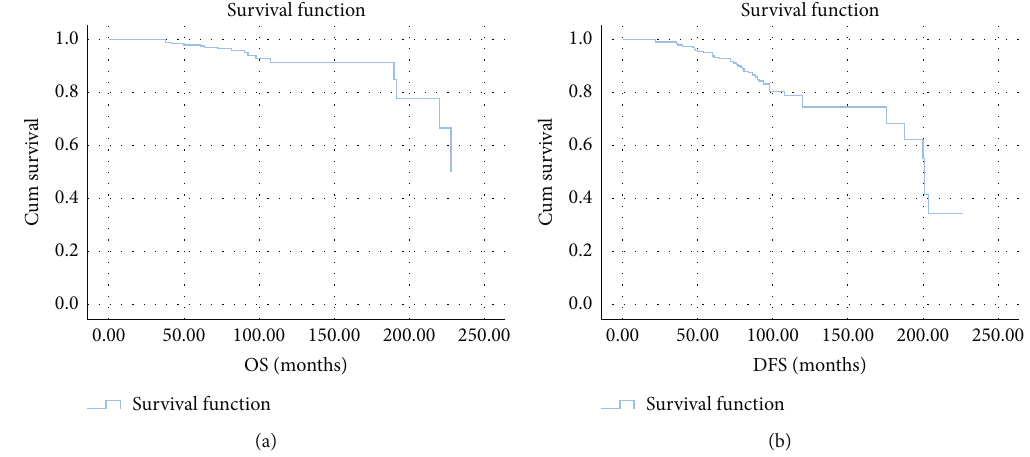
Figure 3: Kaplan Meier analysis of all PTC cases: overall survival (OS) (a) and disease-free survival (DFS)